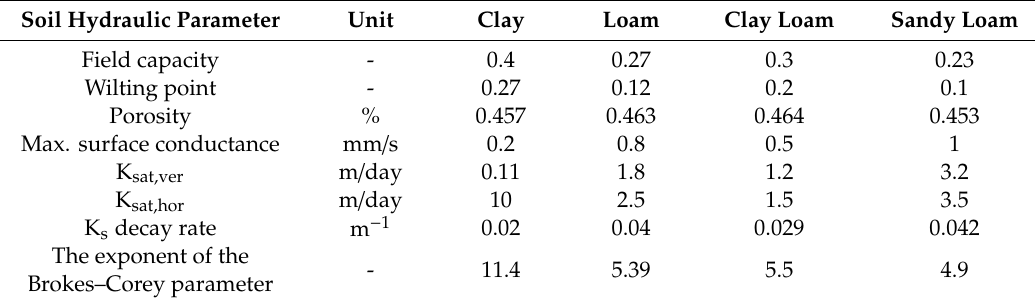
Table 2. Hydraulic properties of four main soil types in the Upper Heihe